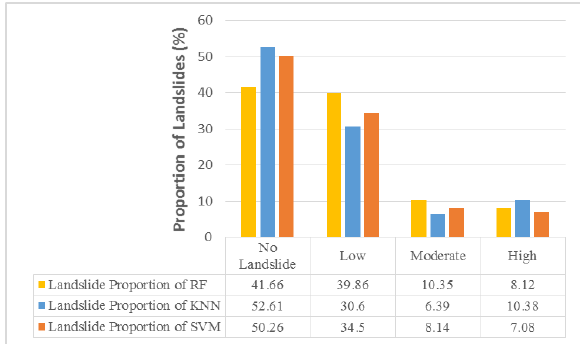
Figure 3. Percentages of different landslide susceptibility